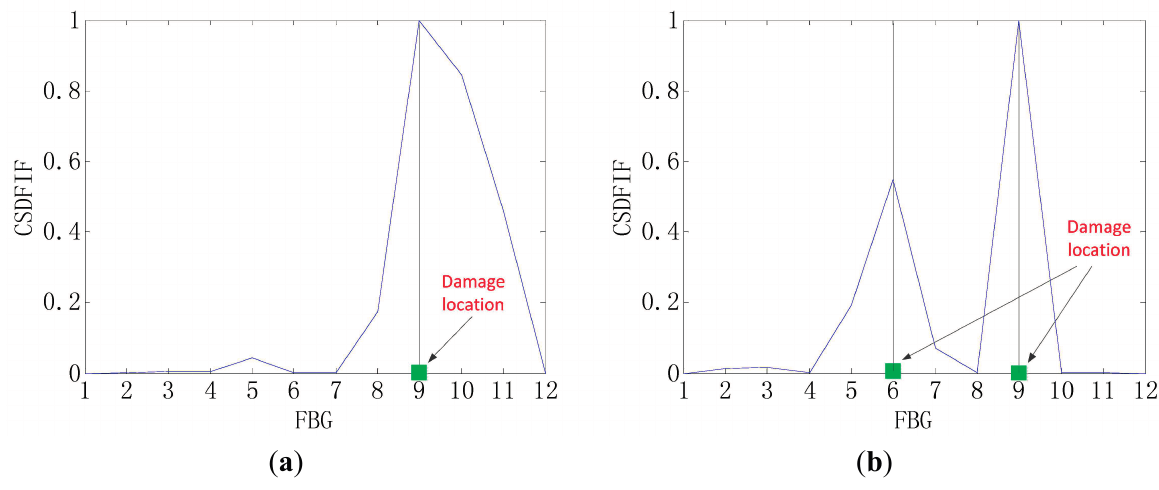
Figure 9. Method of detecting the damage location by the CSDFIF. ( a ) The single-damage detection; ( b ) Two-damage